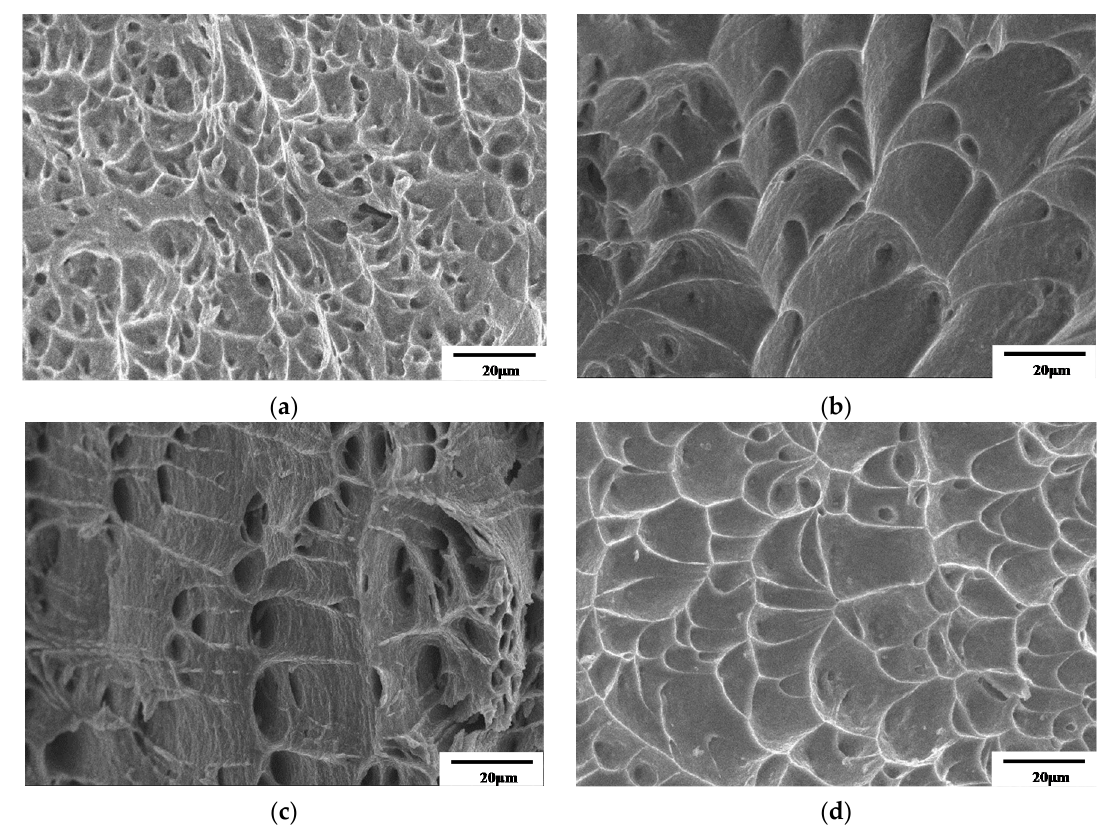
Figure 6. Fracture morphology obtained for TA15 at different forming conditions: ( a ) 700 °C, 1 s − 1 ; ( b )